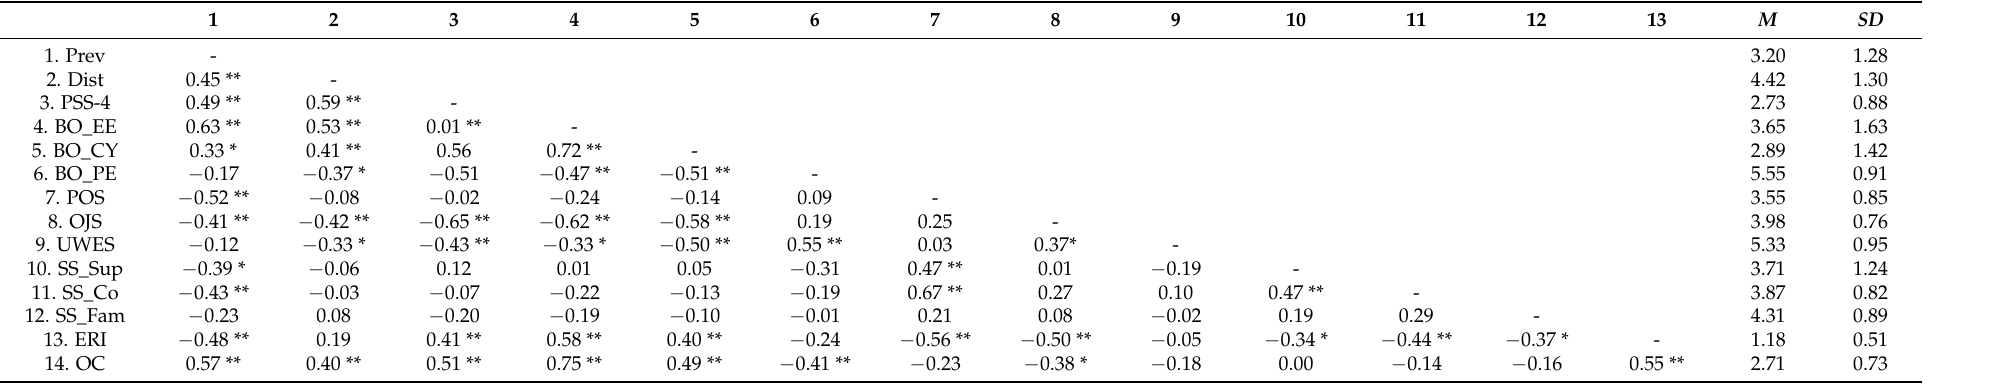
Table 1. Spearman’s rho coefficients, means, and standard deviations for all